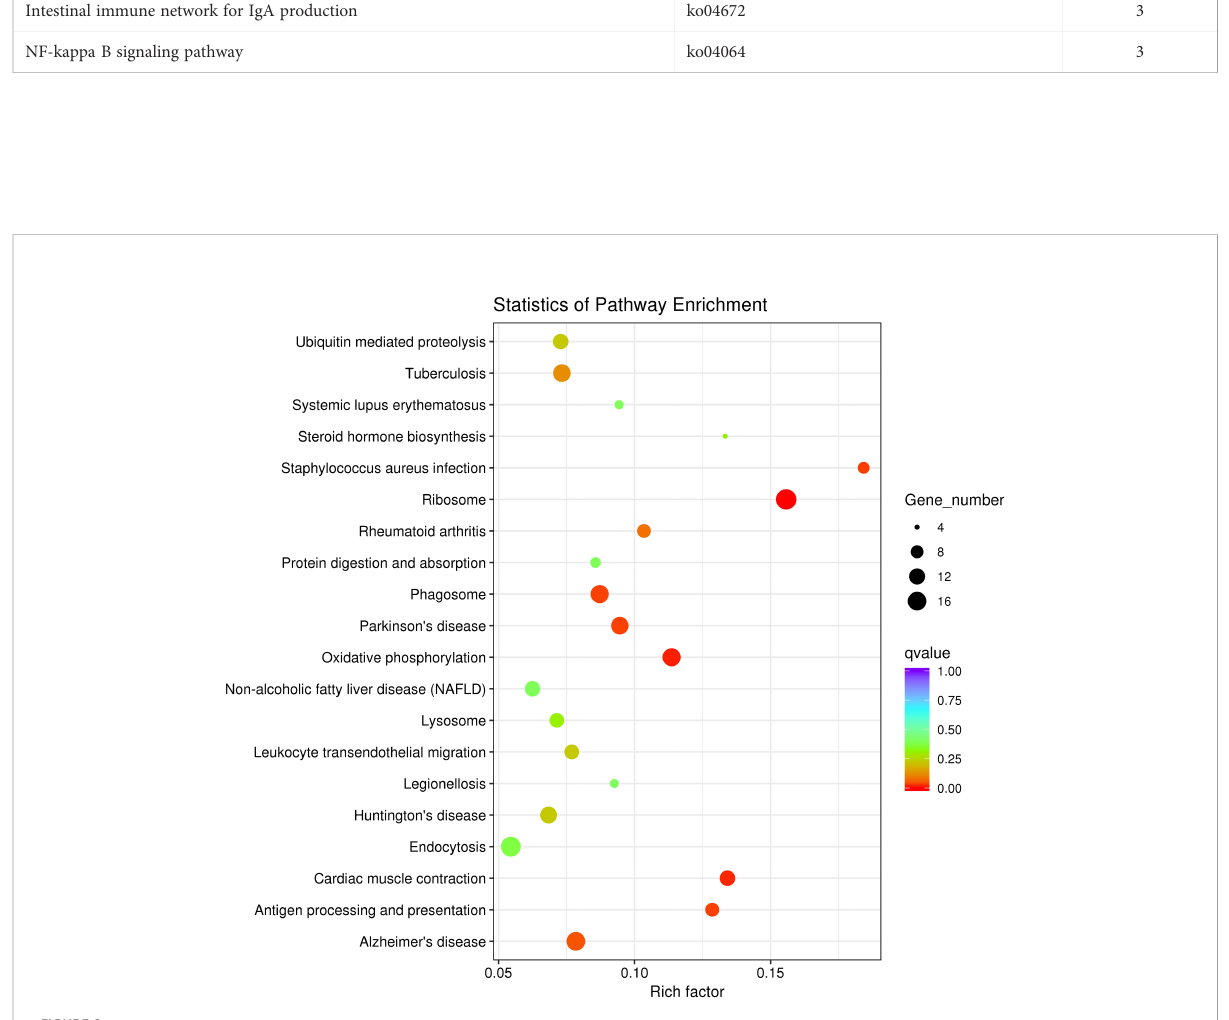
FIGURE 9 Top 20 signi fi cantly enriched KEGG pathways of DEGs.